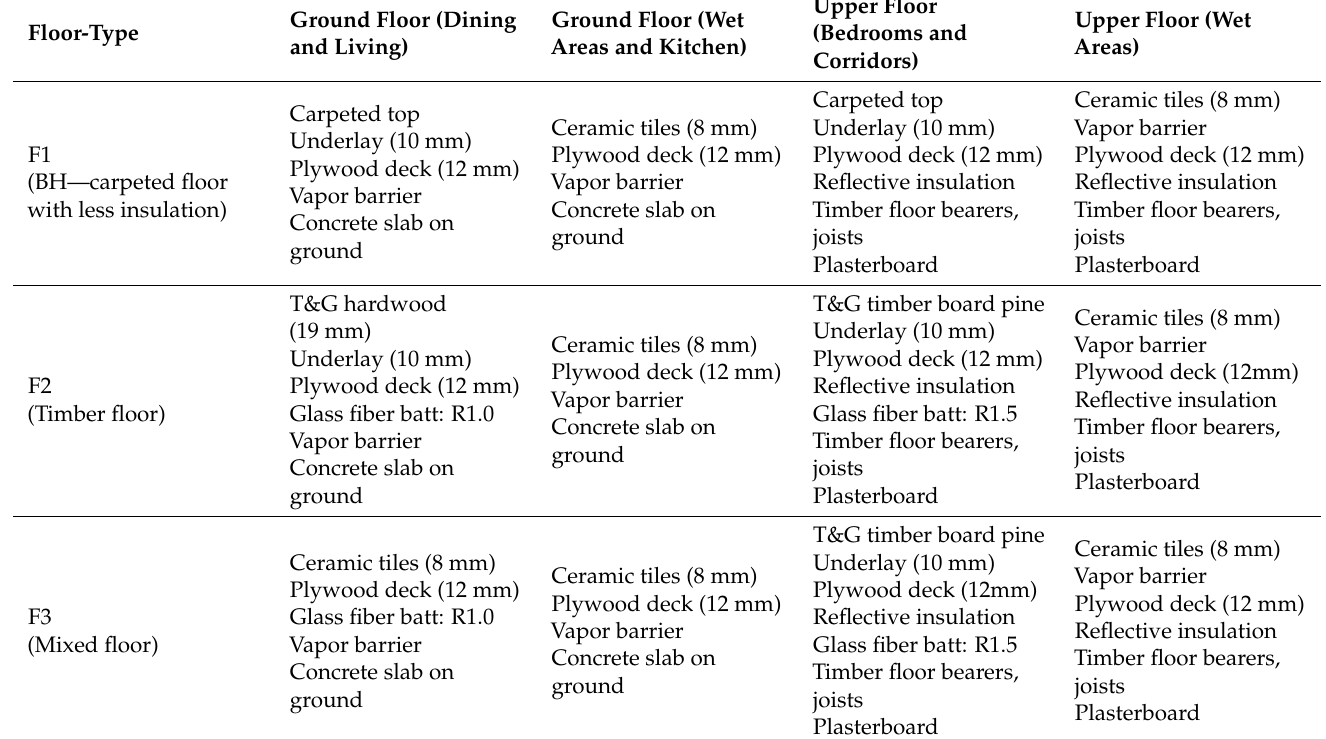
Table 4. Description of floor types.